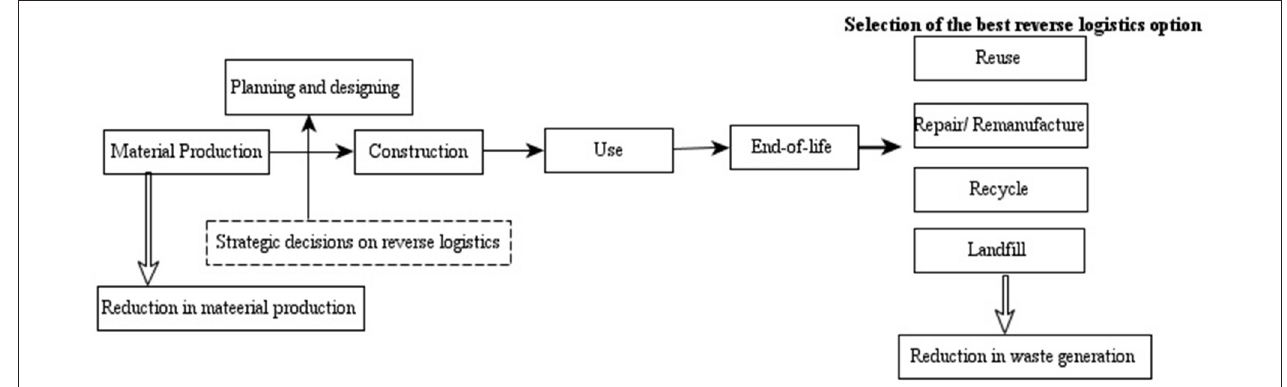
FIGURE 6 | Strategic decision-making